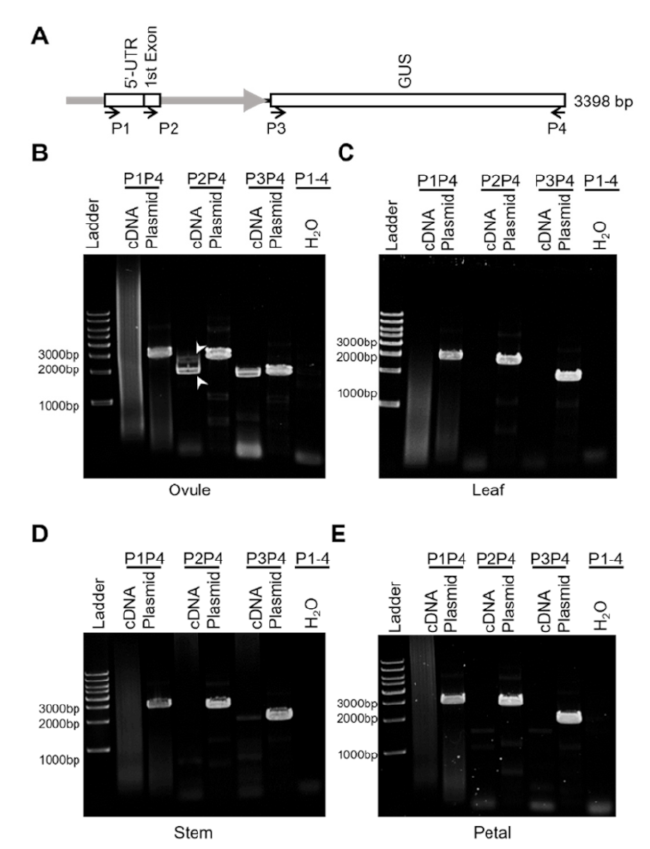
Figure 3. Transcription analysis of proGhROP6::GUS in the transgenic cotton. ( A ) Diagram of proGhROP6::GUS and primer location. proGhROP6 contains the predicted 5 (cid:48) -UTR, the first exon,